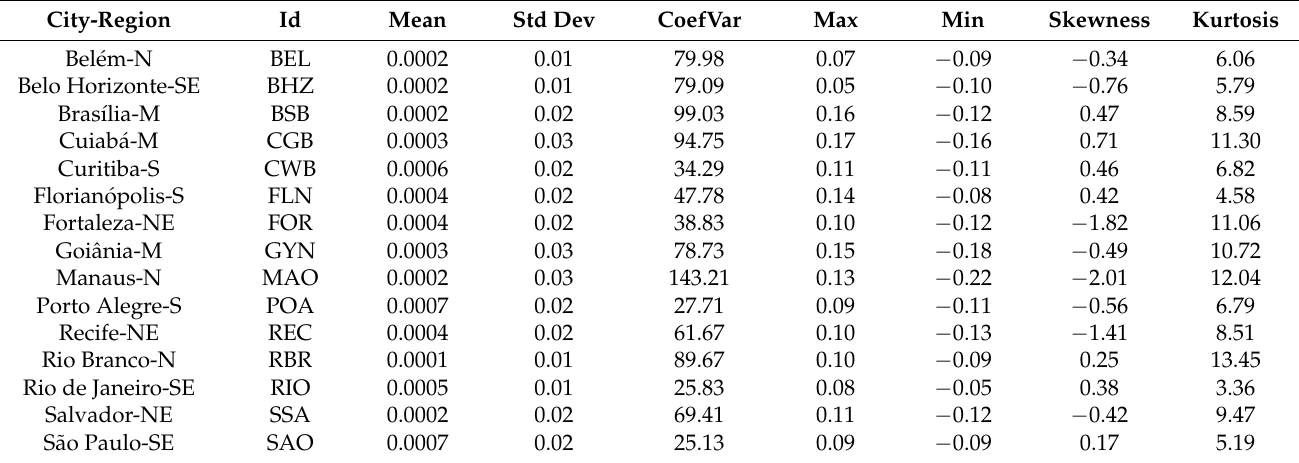
Table 4. Descriptive statistics of hydrous ethanol/gasoline C returns by capitals, between 4 May to 20 December.